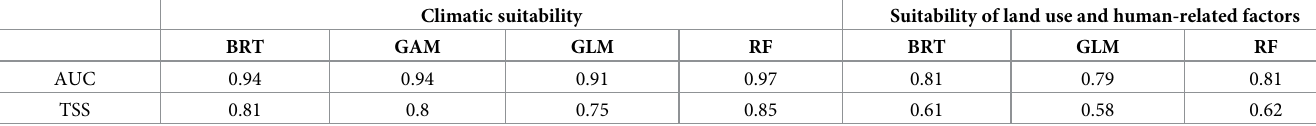
Table 1. Predictive performance of algorithms used in the prediction of climatic suitability and suitability of land use and human settlement patterns. The algo- rithms used were boosted regression trees (BRT), generalized additive models (GAM), generalized linear models (GLM) and random forests (RF). Generalized additive models were not used to assess suitability of land use and human settlement patterns as the number of distribution records was insufficient for model fitting.